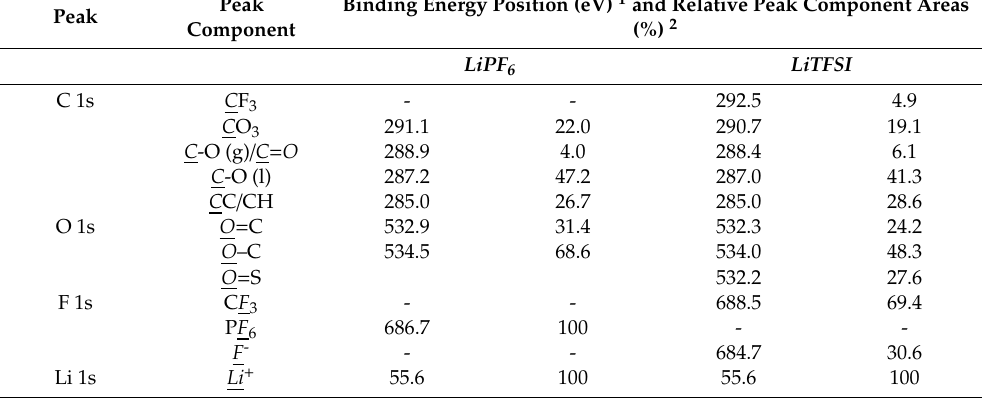
Table 3. Photoelectron peaks, binding energy positions, and relative peak areas of the fitted core-level spectra from LiPF 6 in EC / DMC and LiTFSI in PC as shown in Figure